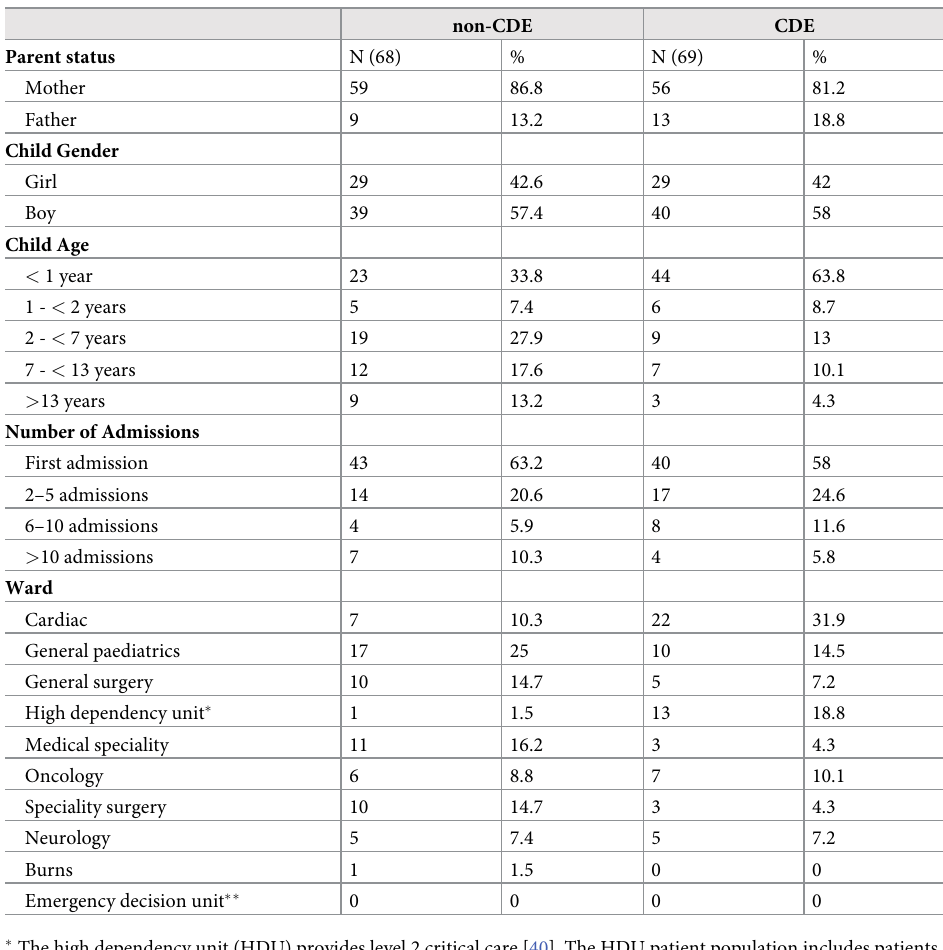
Table 1. Parent and child demographics from parent survey